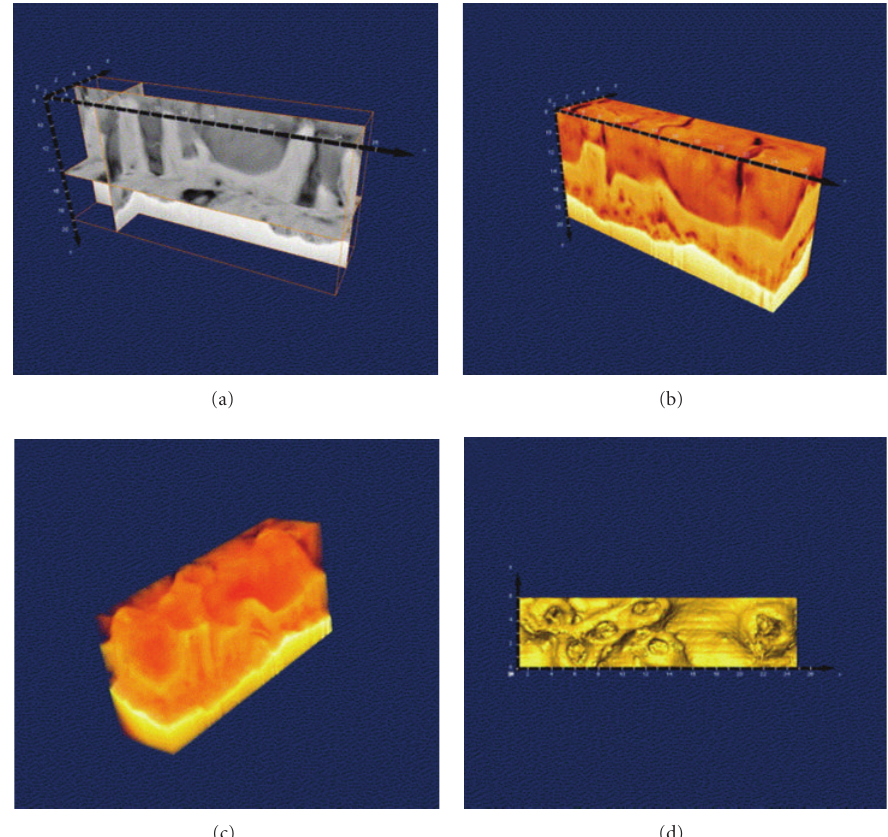
Figure 3: Three-dimensional reconstructions of the TiUnite and bone interface using Slice and View FIB, reproduced with permission from